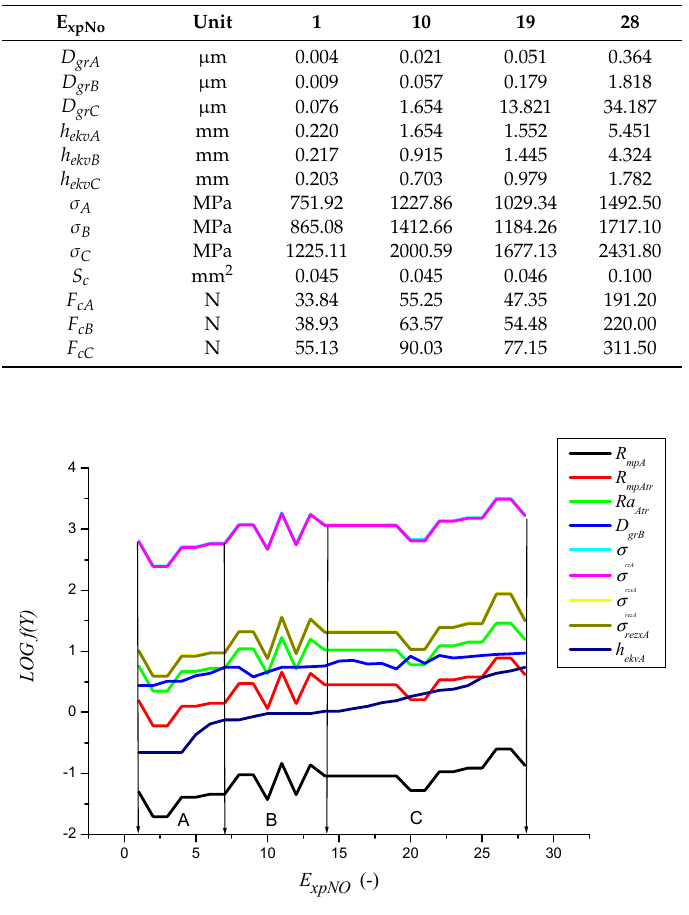
Figure 9. Comparison of working parameters LOG f ( W p ) = f ( E xpNO ) for EN S235JRG1, where: Section A ( E xpNO 1-6) insufficient roughness for the desired adhesion, Section B ( E xpNO 6-13) very good roughness for the desired adhesion, Section C ( E xpNO 13-24) sufficient roughness for the desired adhesion.